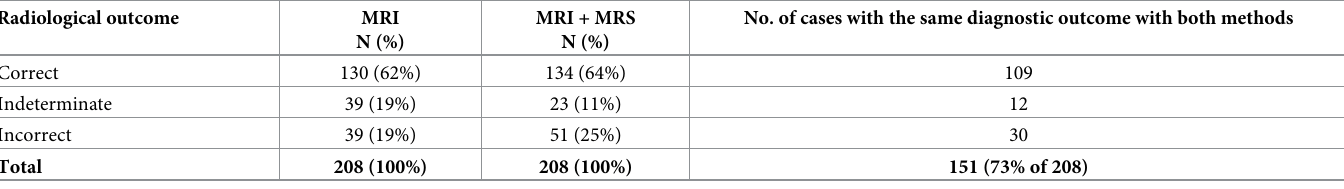
Table 4. Outcome of the radiological diagnostics of the lesions. Comparison between the diagnoses from MRI only and when MRS information was added. Radiological